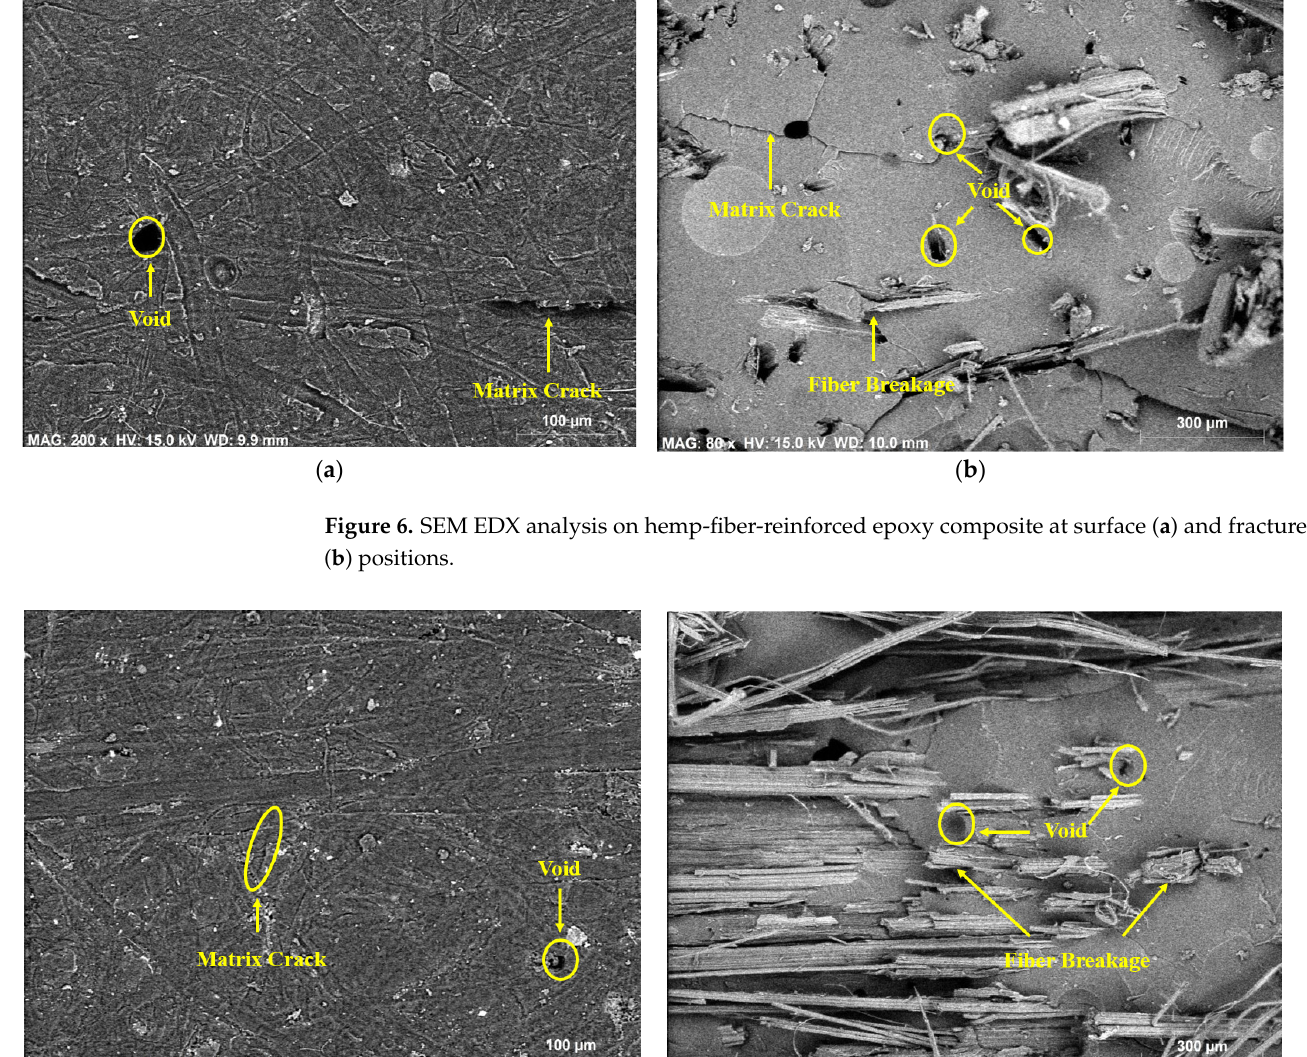
Figure 5. Contact angle measurement of epoxy and ecopoxy composites with various weight fractions.